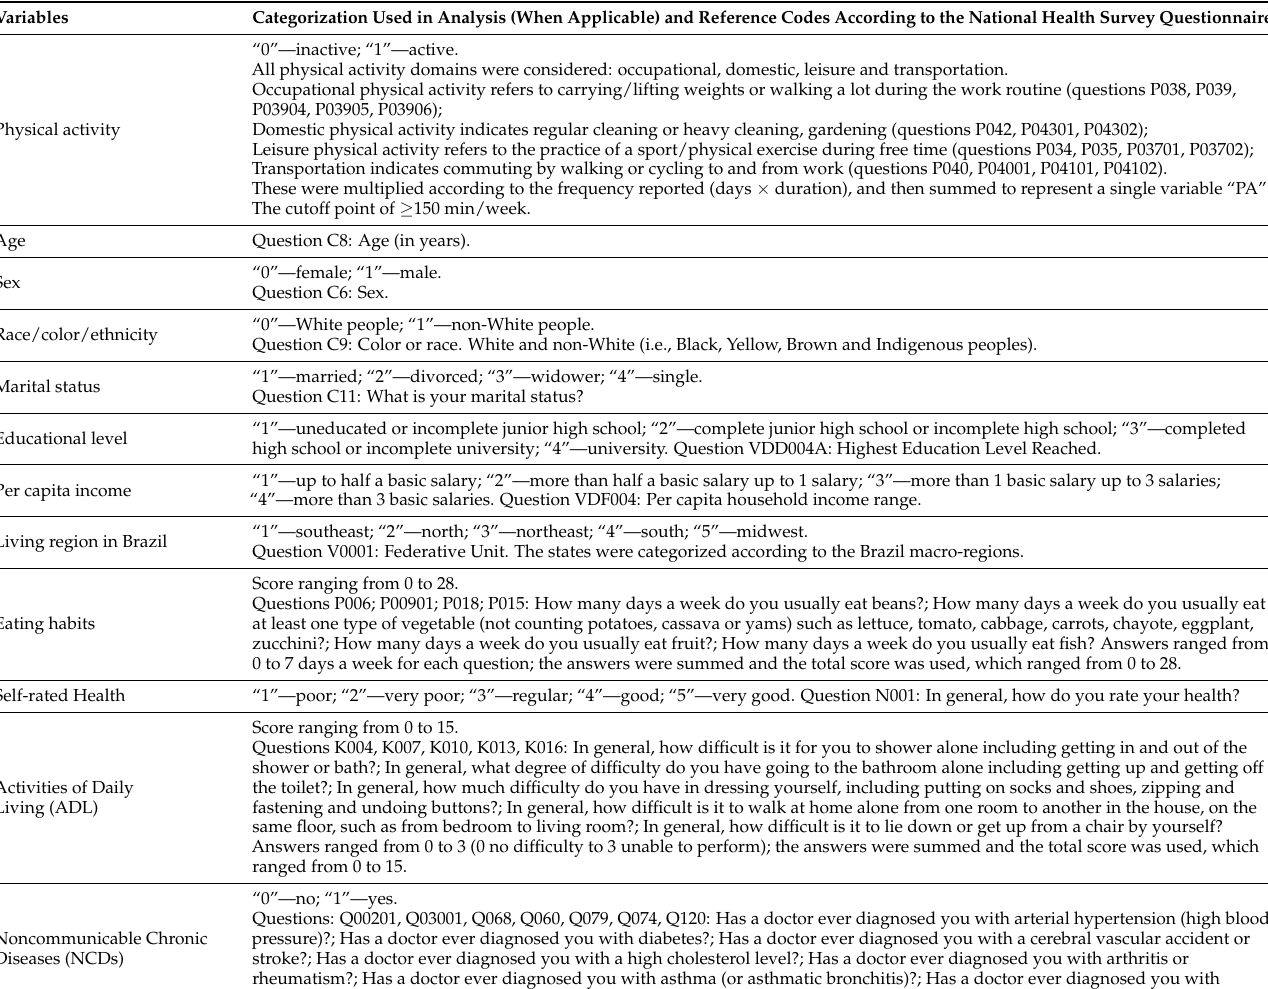
Table 1. Description of the variables used in this